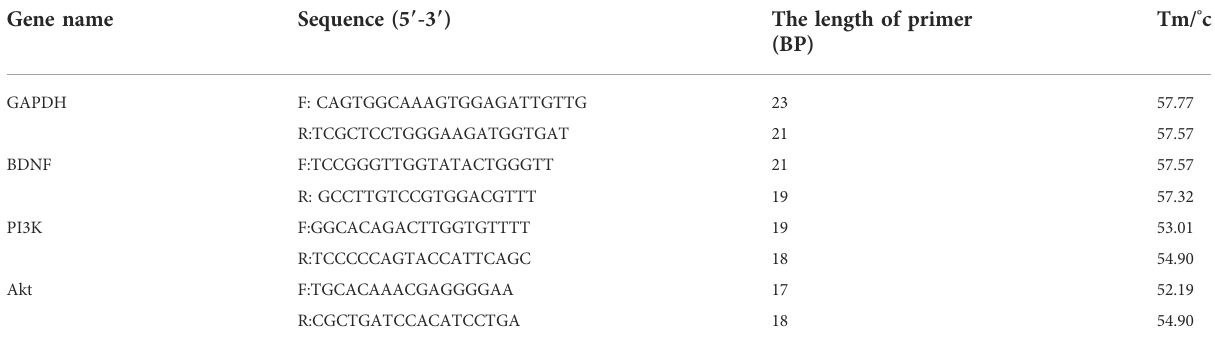
TABLE 1 Primer sequences used for RT-qPCR